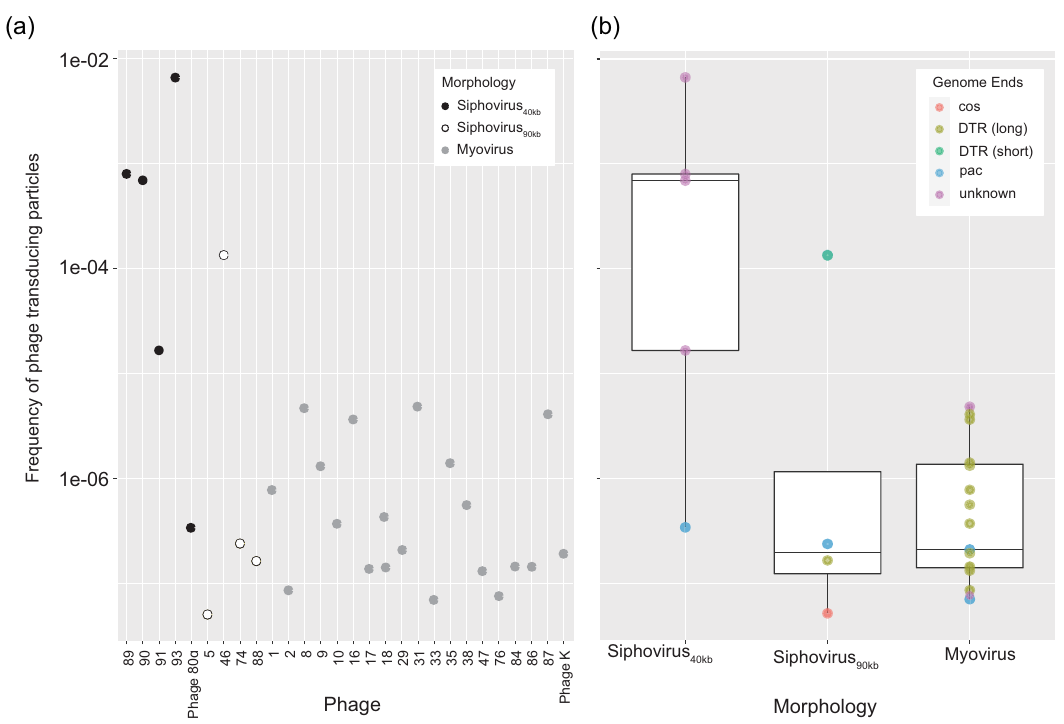
Fig. 7 Frequency of transducing particles for diverse staphylococcal phages. a Estimated frequency of transducing particles for each respective phage and corresponding phage morphology. Phages are abbreviated with their fi nal unique numerical identi fi er (PG-2021_*). b Mean ( + sd) frequencies of transducing particles for each phage morphology, i.e., 40 Kb Siphovirus ( n = 5 phages), 90 Kb Siphovirus ( n = 4), Myovirus ( n = 19). Phage termini were predicted using PhageTerm 100 and are illustrated using colors. DTR: direct terminal repeats. Data are represented as boxplots where the middle line is the median, the lower and upper hinges correspond to the fi rst and third quartiles (the 25th and 75th percentiles), the upper whisker extends from the hinge to the largest value at most than 1.5 X IQR from the hinge (where IQR refers to the range between the fi rst and third quartile) and the lowest whisker extends from the hinge to the smallest value no further than 1.5 X IQR, while data beyond the end of the whiskers are outlying points ( b ). All datapoints are plotted individually. Source data are provided as a Source Data fi